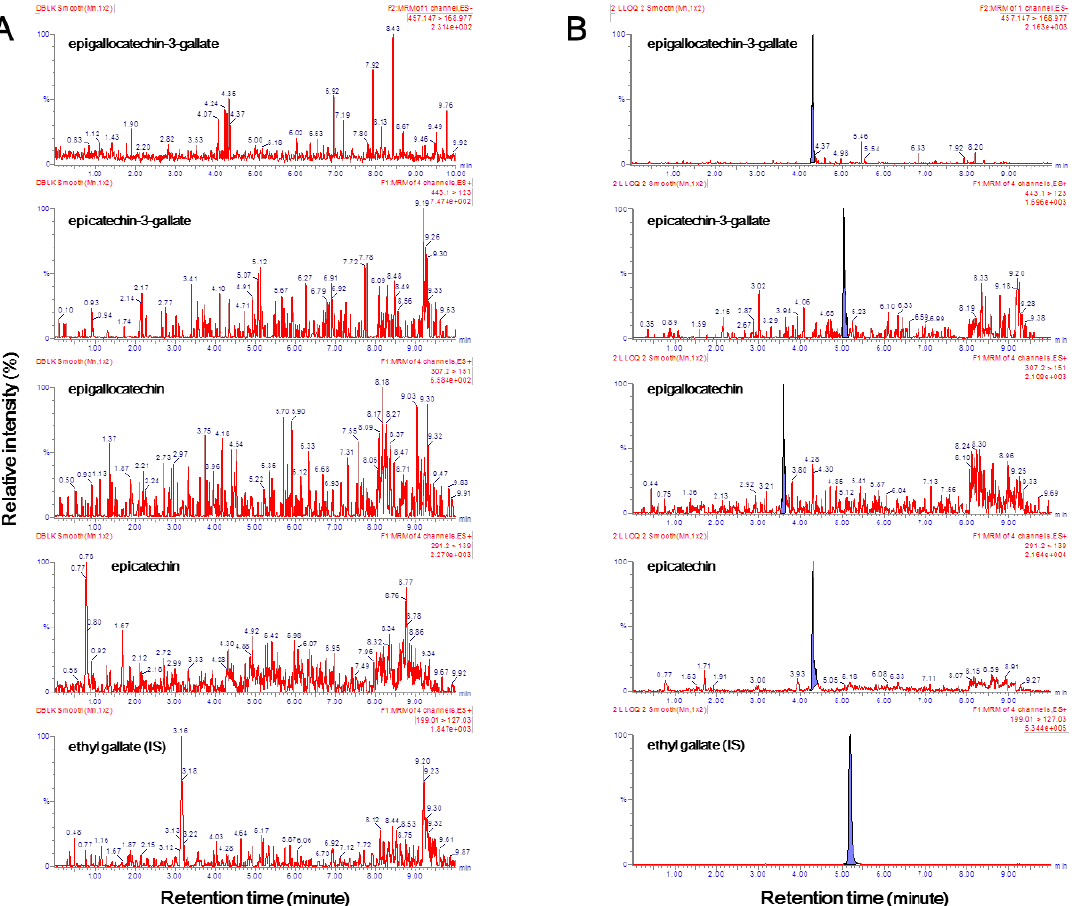
Figure 2. Representative chromatograms of ( A ) double blank human plasma and ( B ) spiked with EGCG, EGC, EGC, and EC at the LLOQ. EGCG, epigallocatechin-3-gallate; ECG, epicatechin-3-gallate; EGC, epigallocatechin; EC, epicatechin. Signal-to-noise ratios for EGCG, ECG, EGC, and EC were 76.93, 20.69, 14.16 and 54.70, respectively in Figure 2B.